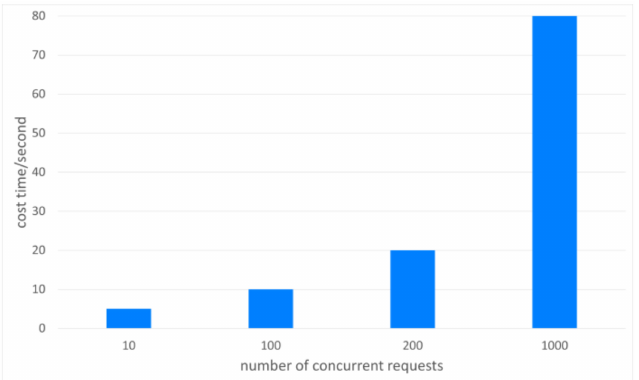
Figure 24. Time cost of Access Contract (AC).